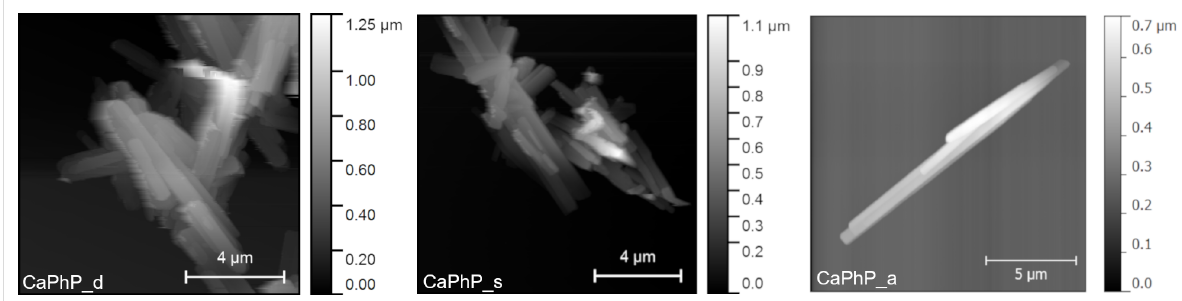
Figure 3: AFM images illustrating the topology of CaPhP particles prepared by addition of calcium chloride solution: “drop by drop” (CaPhP_d), “in several portions” (CaPhP_s) and “all at once” (CaPhP_a).